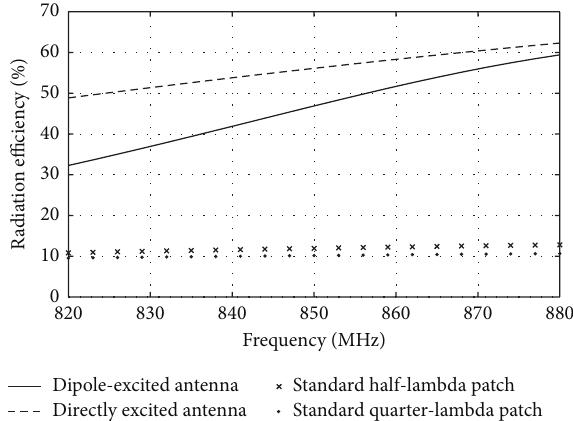
Figure 3: A comparison of the radiation efficiency of standard patch and coupled shorted-patches antennas using the same substrate and footprint size (60 × 100 × 0.76